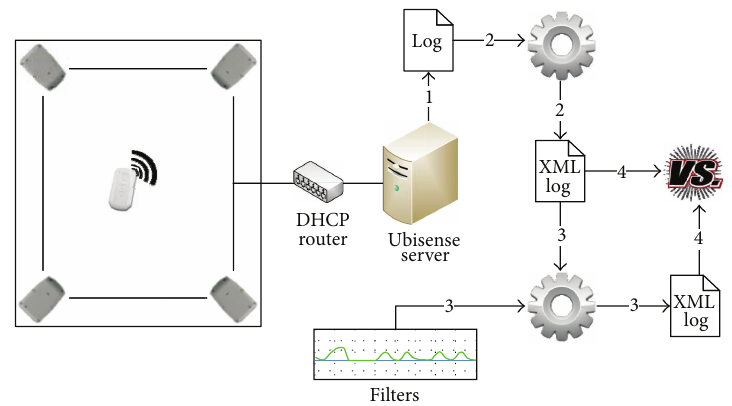
Figure 1: Global project